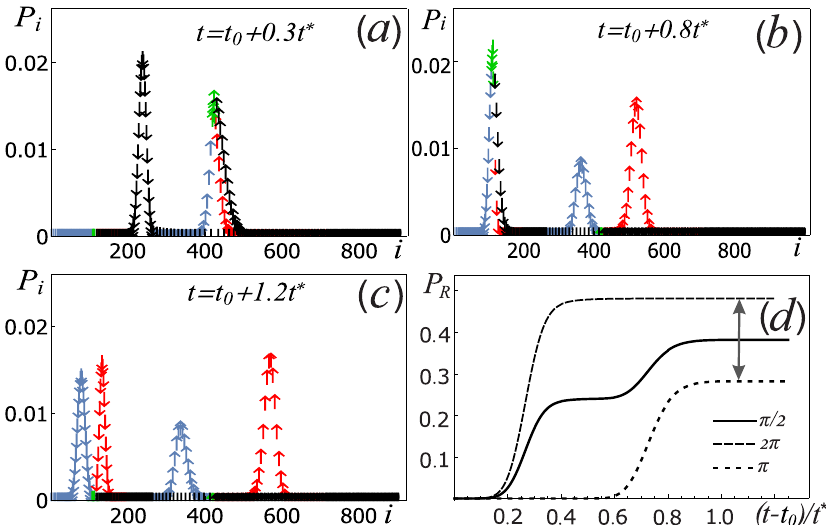
Figure 8. ( a – c ) Time evolution of the diagonal elements of the system density matrix P i in the process of the qubit measurement at different times. ( d ) The dependence of the capture probability into the right equilibrium point P R as a function of time for different Rabi pulses. At the initial moment of time, the qubit was initialized to the ground state. The use of colored arrows is the same as in Figure 6a,b. The system parameters used are determined by the ratios